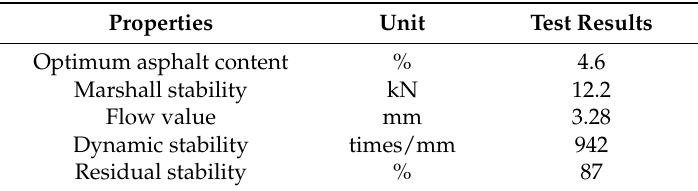
Figure 1. Aggregate gradations of hot mix asphalt (HMA) and cement emulsified asphalt mixture (CEAM). Table 6. Properties of hot mix asphalt (HMA).